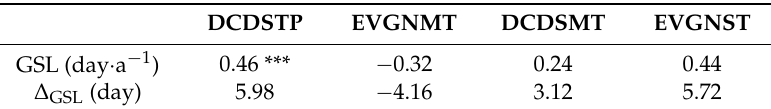
Table 4. Temporal trends in the length of growing season in 2001–2013. GSL stands for growing season length and ∆ GSL denotes the changes in the growing season length between 2001 and 2013. p values were based on one-tailed hypothesis, and “***” is for p -values less than 0.01.